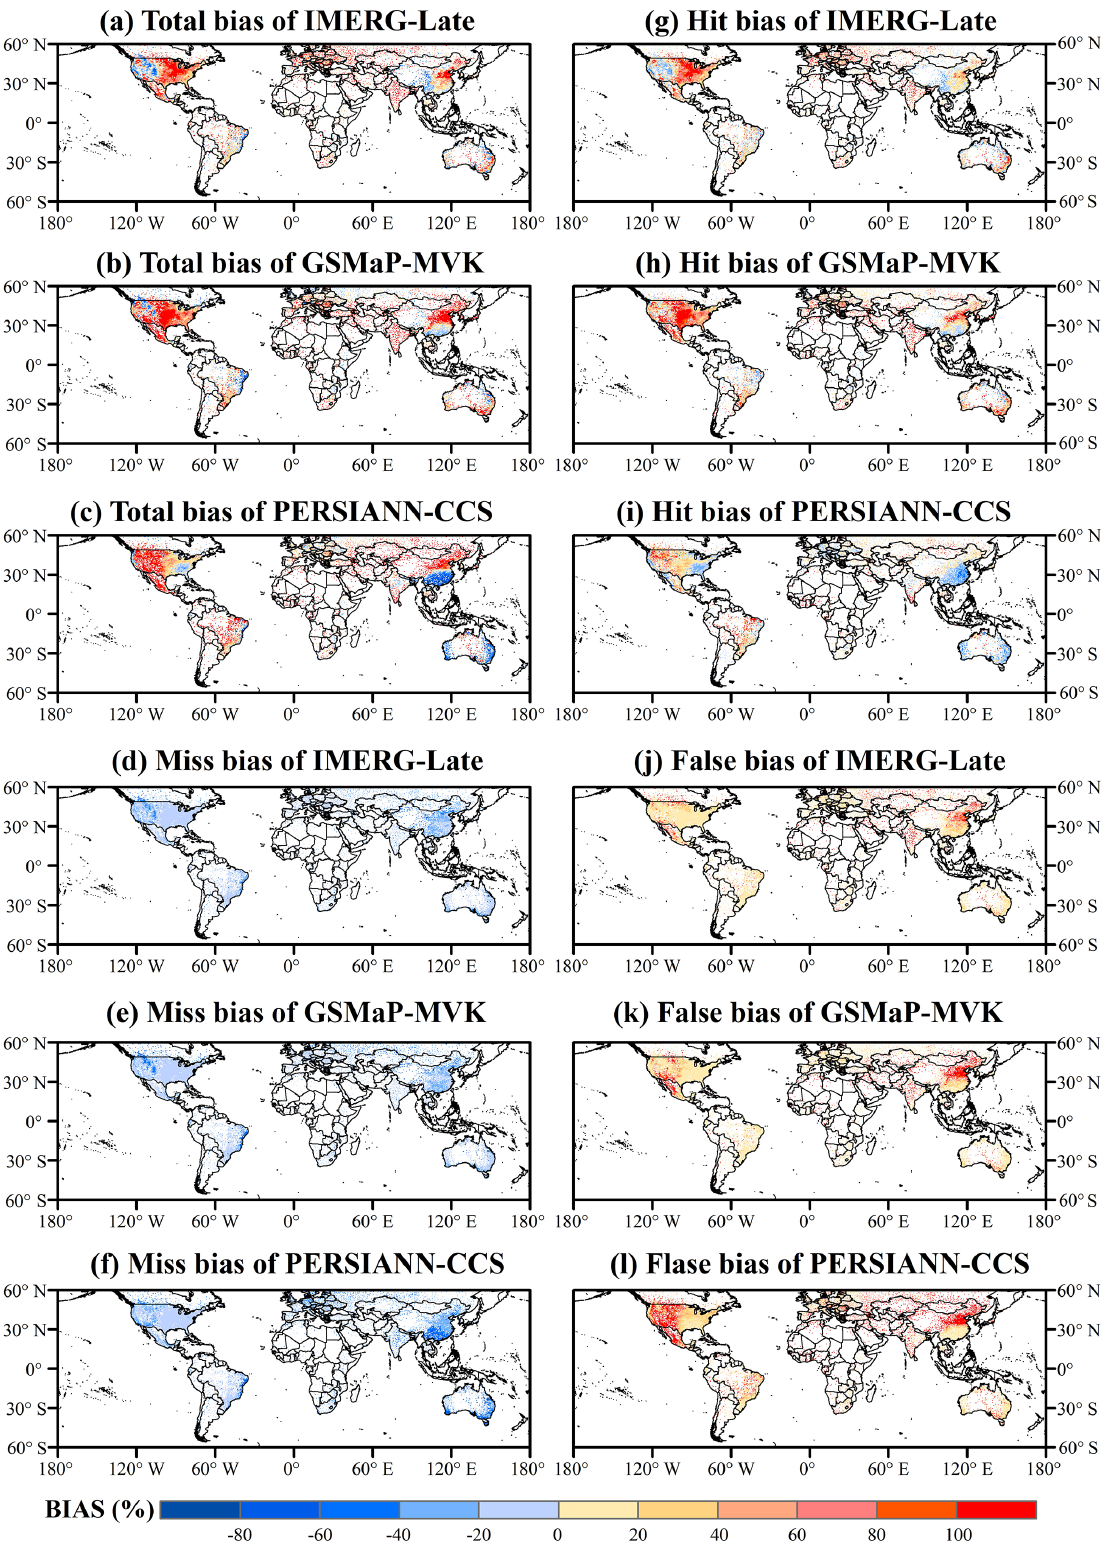
Figure 2. Global land maps of the total bias and its three independent components for the three satellite-only global precipitation estimates (i.e., IMERG-Late, GSMaP-MVK, and PERSIANN-CCS) at a spatial resolution of 0.5 ◦ and daily temporal resolution during the MAM season (March–May) for the period from 2015 to 2019 (5 years): (a–c) total bias, (d–f) miss bias, (g–i) hit bias, (j–l) false bias. Hydrol. Earth Syst. Sci., 25, 3087–3104,